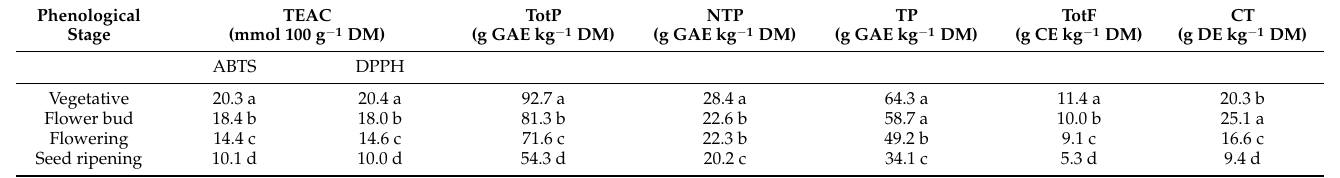
Table 2. Total antioxidant capacity (TEAC) by ABTS and DPPH methods, total phenolics (TotP), non- tannic phenolics (NTP), tannic phenolics (TP), and total flavonoids (TotF) and extractable condensed tannins (CT) in the examined Sulla coronaria